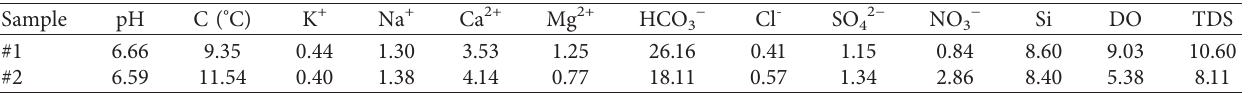
Figure 2: Schematic diagram of the experimental setup. Table 1: Statistical results for conventional chemical parameters of groundwater (mg · L − 1